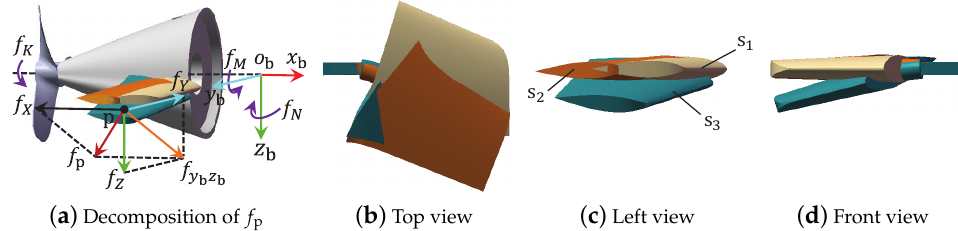
Figure 3. Deformed faults on R R outside the hull, where ( a ) reveals the decomposition of the additive resultant force f p , ( b – d ) provide respectively the top, left, and front views of the rudders for comparisons, s 2 and s 3 represent respectively the deformed rudders from impacts with 0 ◦ and 15 ◦ initial rudder angles, and s 1 indicates a fault-free rudder.